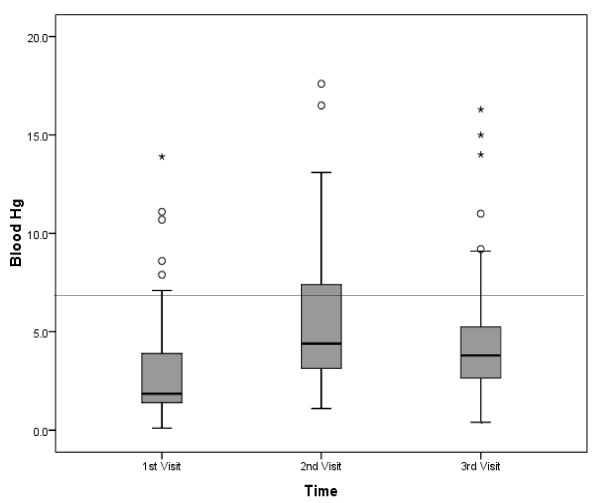
Blood-Hg levels for each visit (n = 56).a Blood-Hg values in μg/l. Medians are middle lines within box. Top and bottom of box represents upper and lower quartile values, respectively. Upper and lower whiskers represent sample maximum and minimum values, respectively. Values marked with “°” and “*” are outliers as defined by being 1.5x and 3x the interquartile range, respectively. Four (25.1, 29.3, 35.0 and 44.3), three (23.7, 24.3 and 28.2) and one (33.9) blood-Hg values are not depicted for the 1st, 2nd and 3rd visits, respectively, as they are off the scale provided. Distribution mean values do not differ significantly (p <0.05). Horizontal line represents 5.8 μg/l blood-Hg (the RfD equivalent).